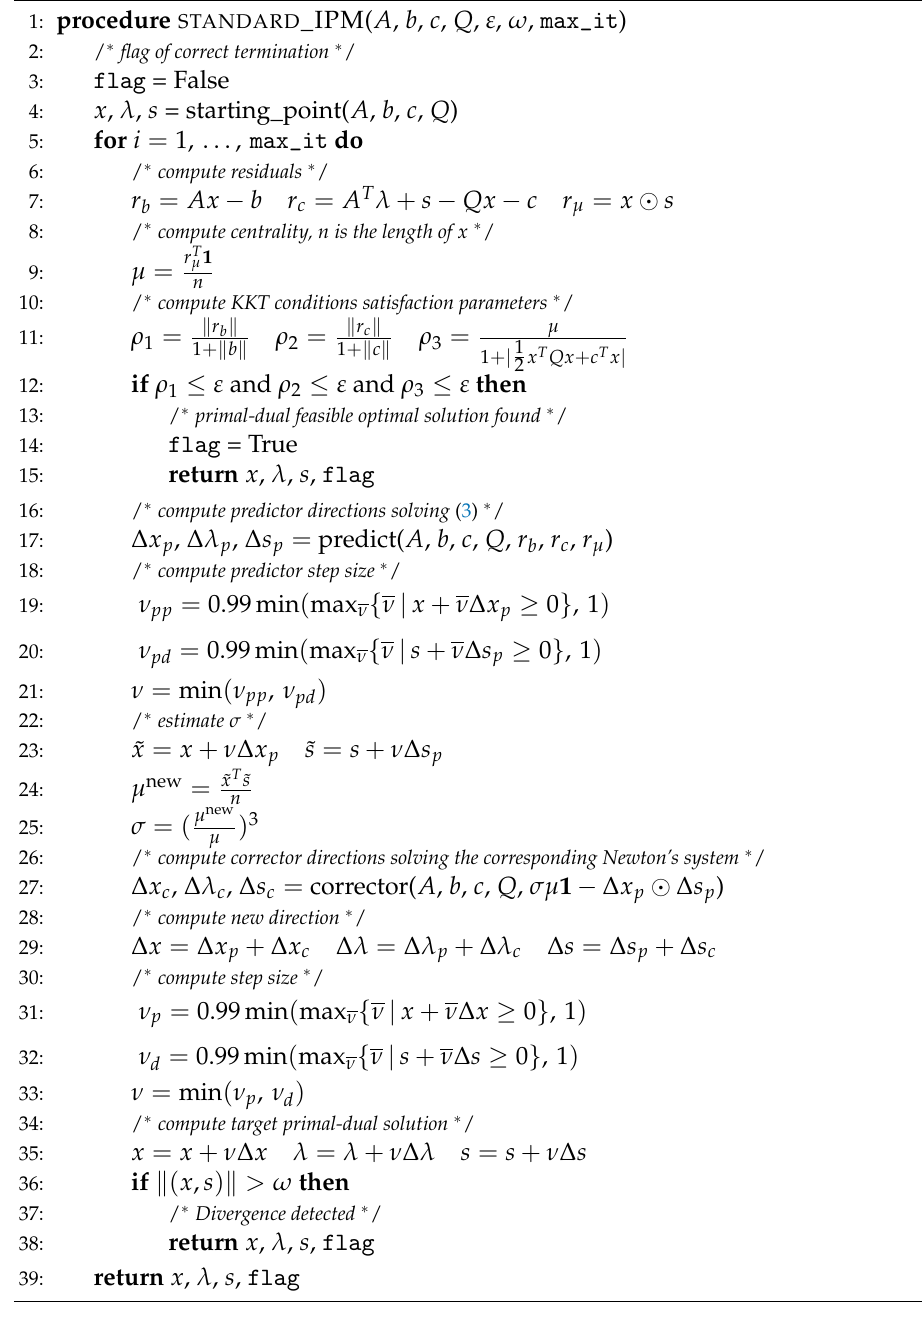
Algorithm 2 Predictor–corrector infeasible primal-dual